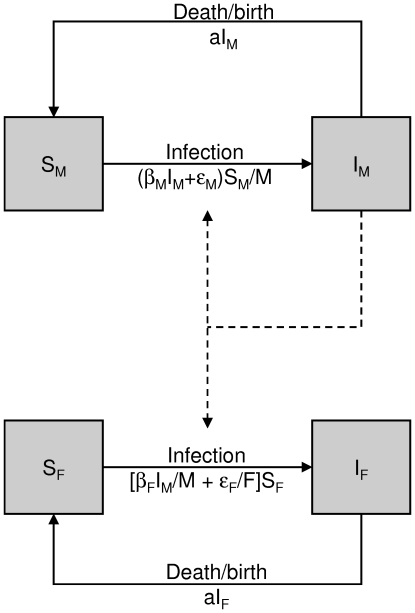
Compartmental representation of the model.The model includes both males (susceptible, SM or infected, IM) and females (susceptible, SF or infected, IF). Dashed arrows illustrate the fact that infected males are responsible for FIV transmission to both susceptible males and females.